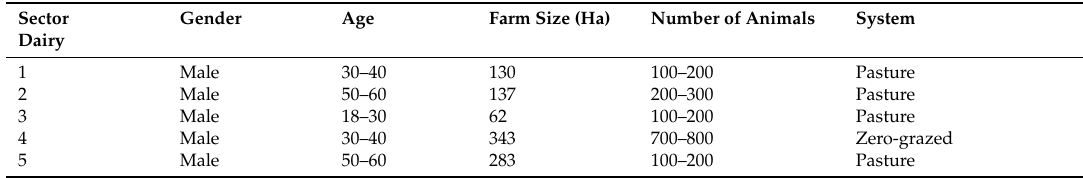
Table A1. Farmers’ demographic